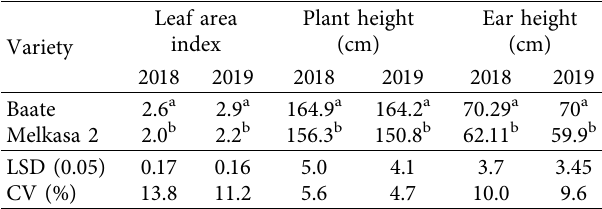
CEC (meq/100 g soil) Table 4: Mean values of leaf area index as affected by interaction effect of variety × NPS × N in the 2018 cropping season. Treatments